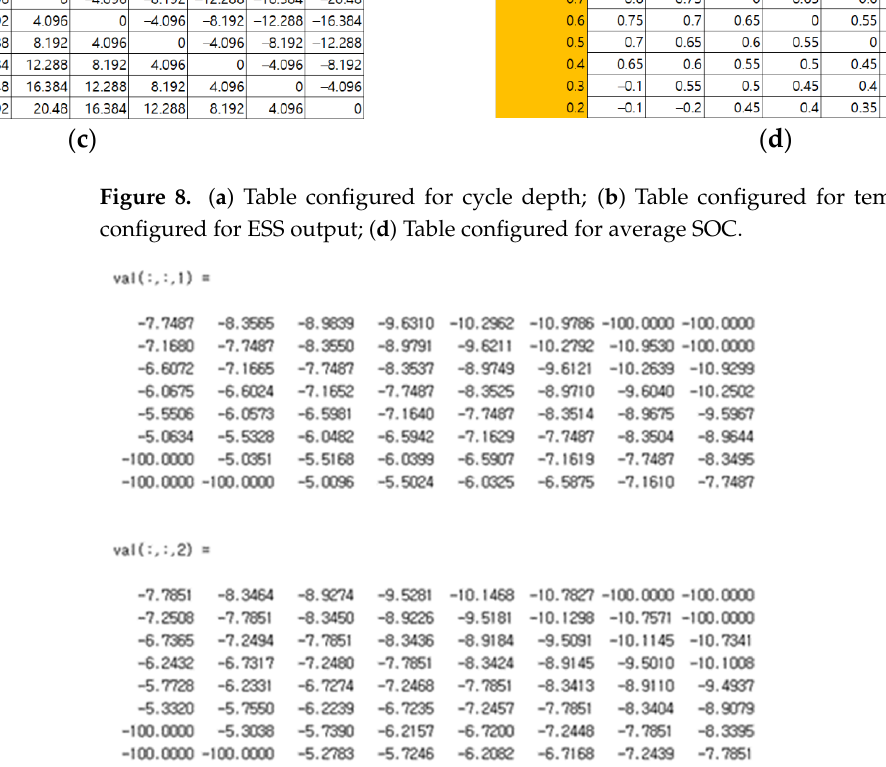
Figure 9. Example of a reward table constructed on MATLAB.